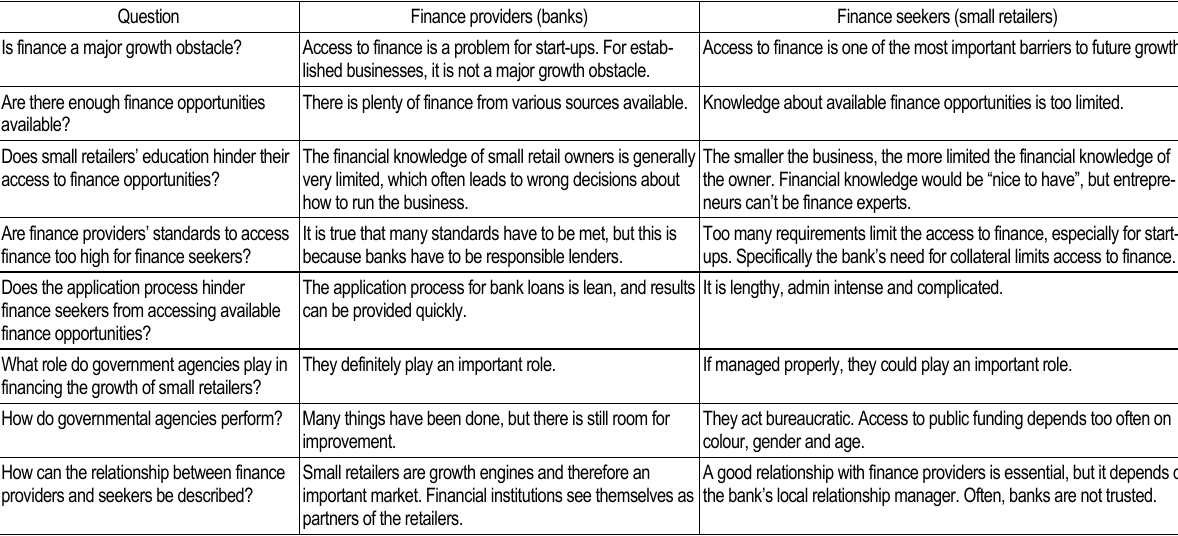
Table 2. Outline of the views of finance providers and